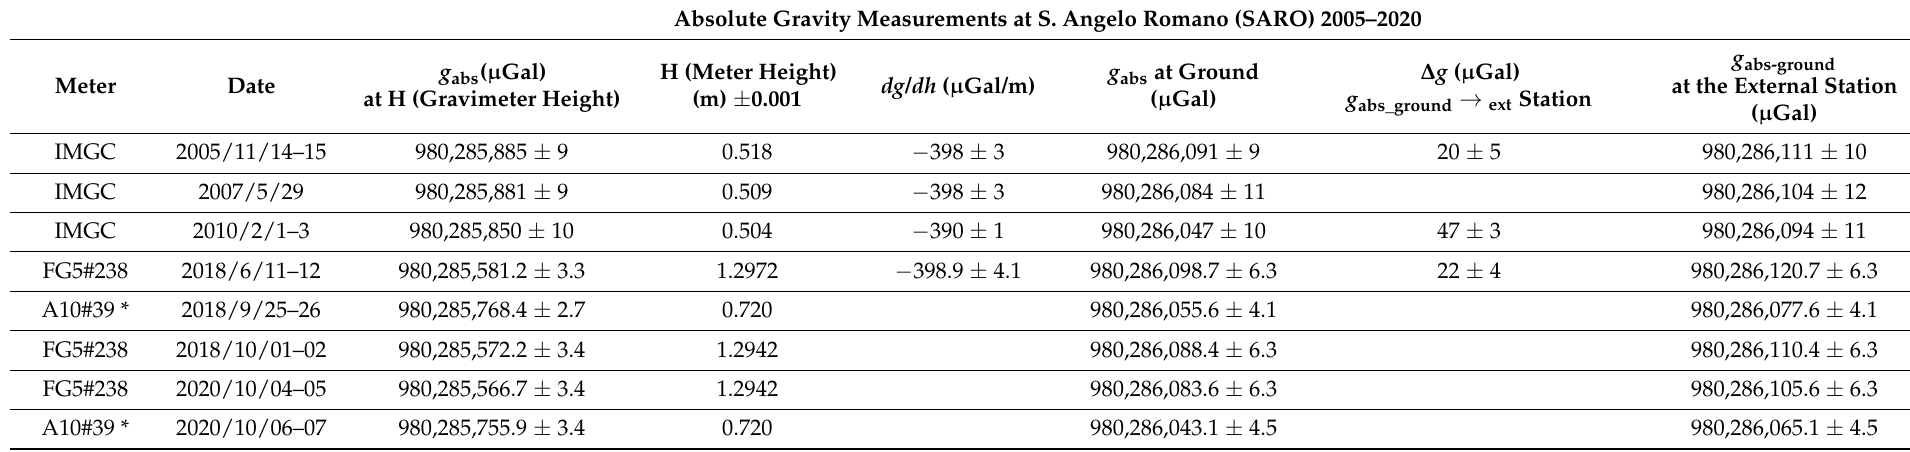
Table 9. Repeated absolute gravity measurements collected at S. Angelo Romano (SARO) station from 2005 to